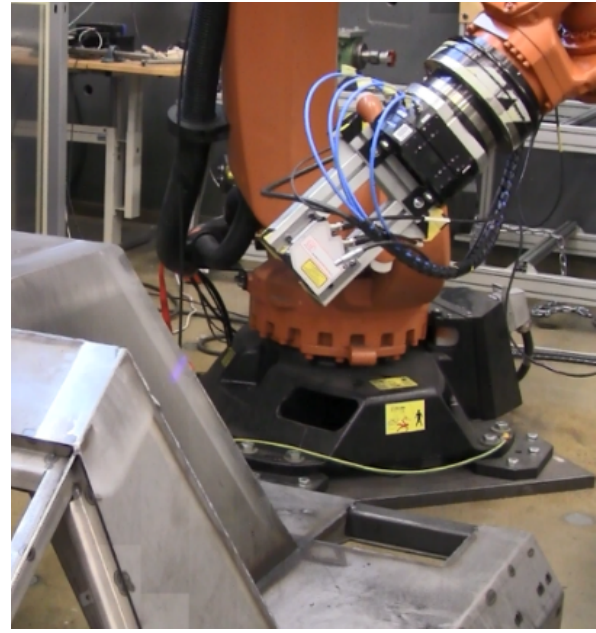
Figure 9: Scanning the object with microEpsilon 2900-100/BL profile scanner [12]